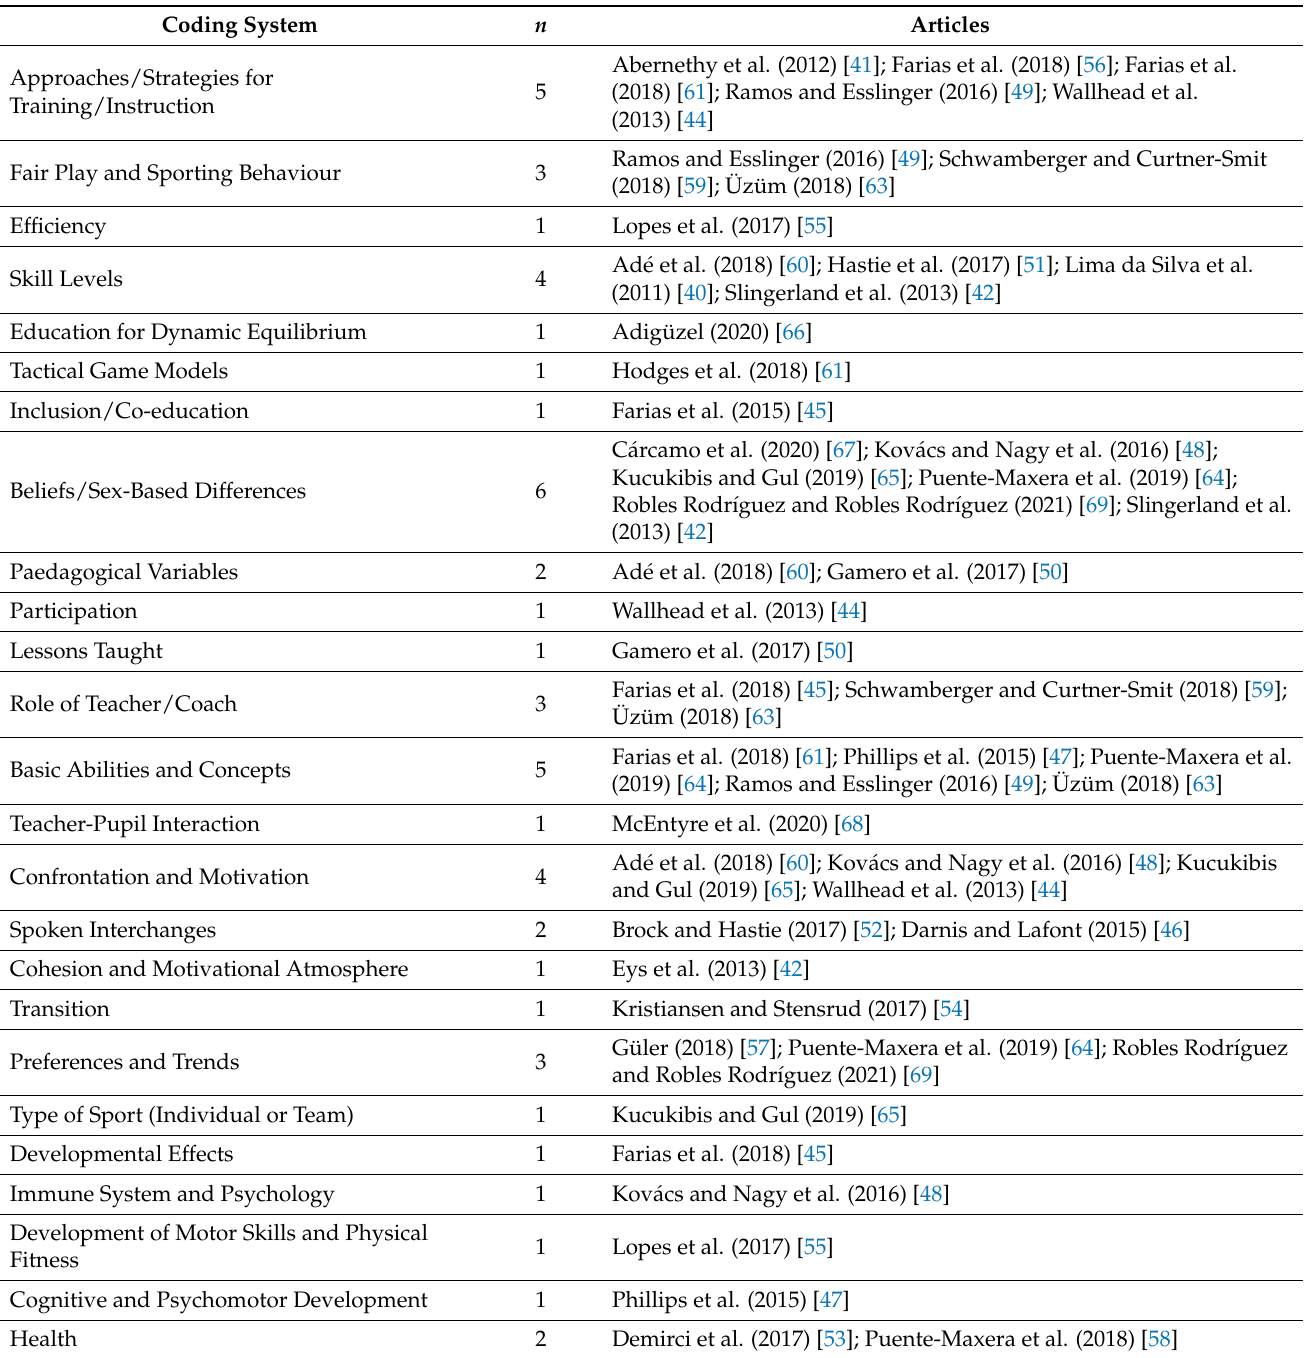
Table 2. Objectives of the Selected